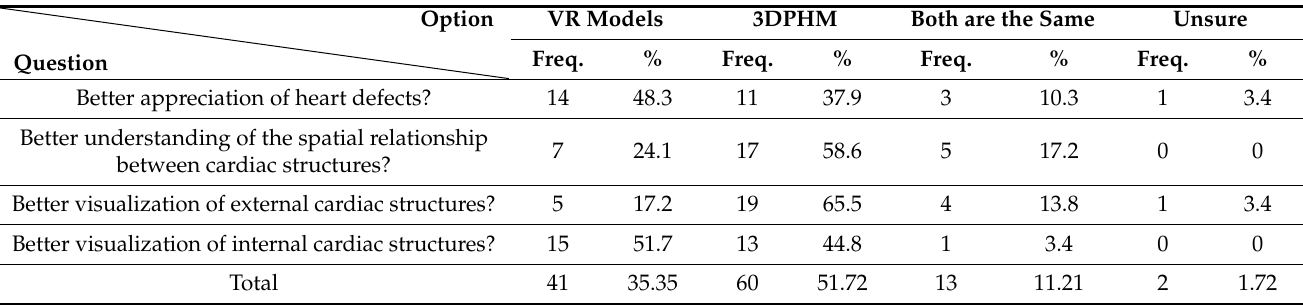
Table 1. Participants’ responses on the degree of realism of the VR and 3DPHM. Option Question Better depth perception? Better and more comprehensive viewing